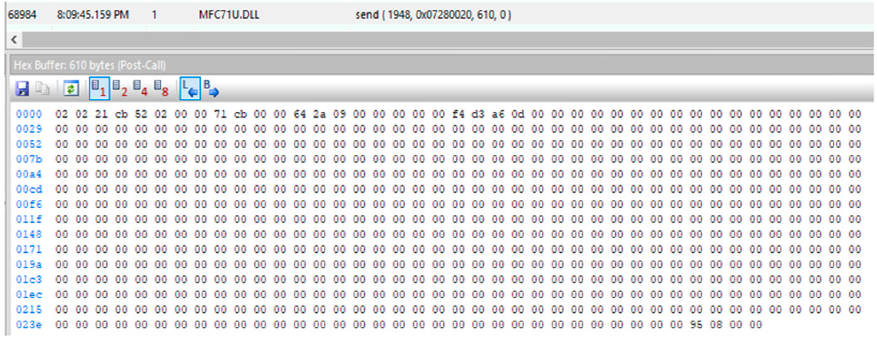
Figure A2. Initial data sent by the receiving client to the sending client.